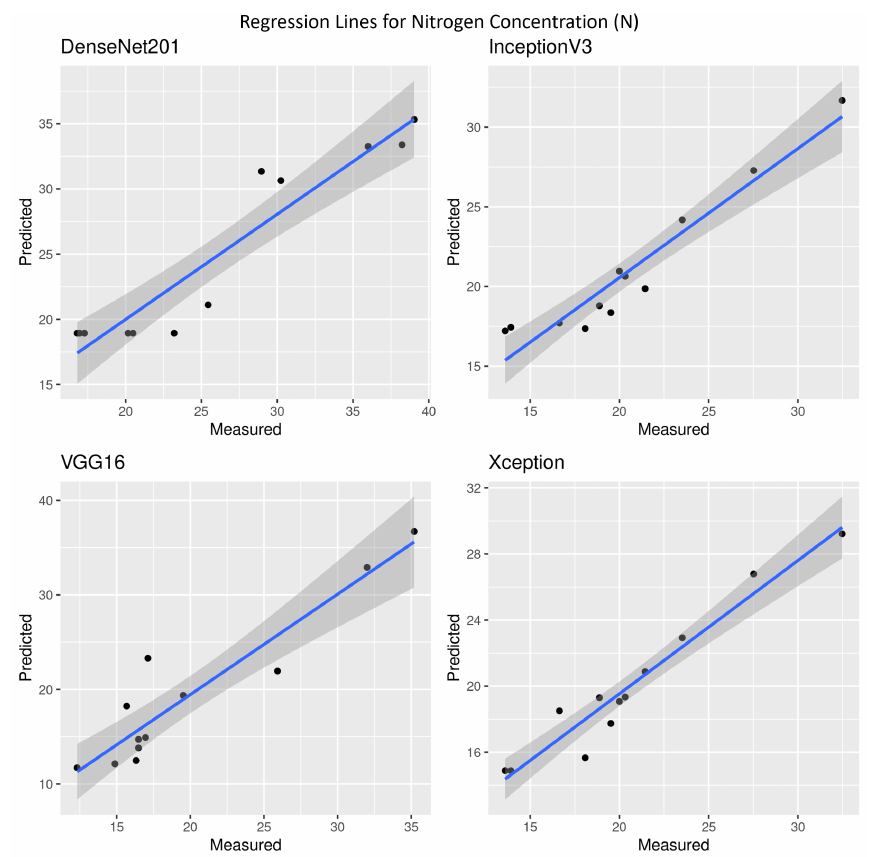
Figure 6. XY graphics for predicted versus measured nitrogen concentration (N) points arising from the best run for each architecture. The regression lines are shown in blue and the grey area is the confidence